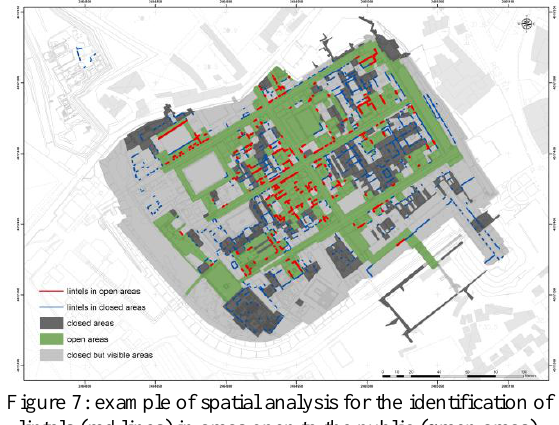
Figure 7: example of spatial analysis for the identification of lintels (red lines) in areas open to the public (green areas).